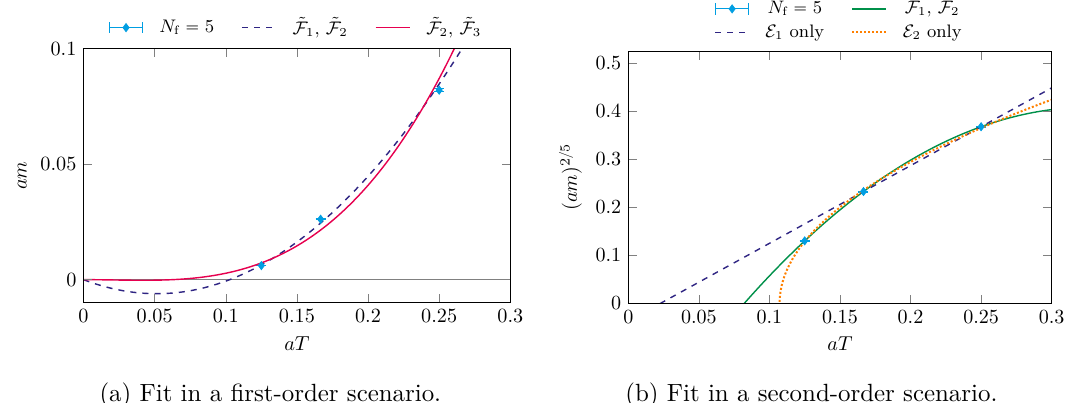
Figure 8. Chiral critical line for N f = 5 . Fits from table 4 pertaining to a first-order scenario, eq. (4.5), do not describe the data. The data are instead consistent with a second-order scenario. In (b) the green solid line interpolates the data according to eq. (4.7) truncated at next-to-leading order. Dashed and dotted lines represent interpolations according to eqs. (4.8) and (4.9), respec-